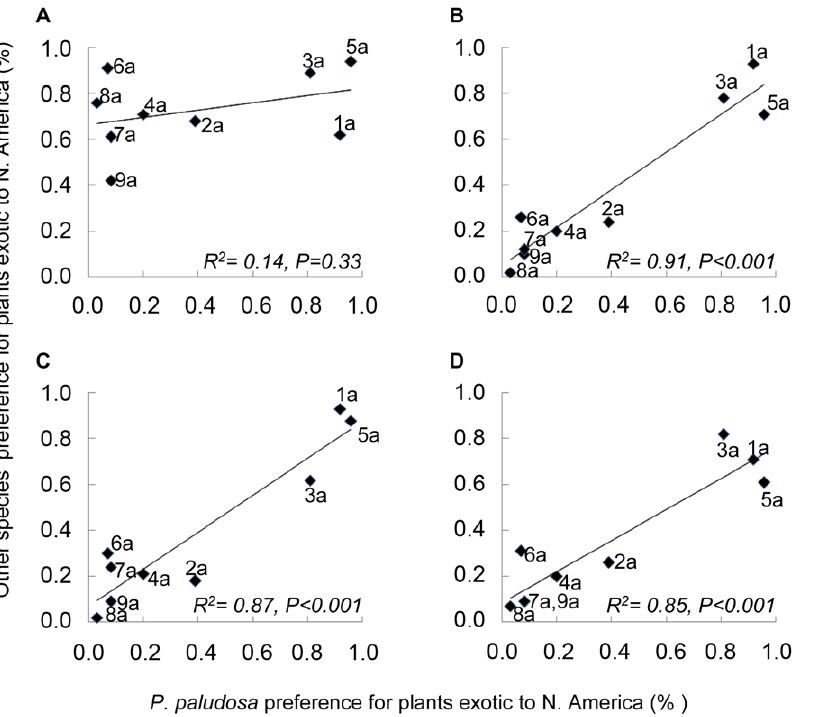
Figure 2. Plant preferences of the native P.paludosa correlated with preferences of the other herbivores. Preferences for all species were calculated as the percentage of plant consumed that was exotic to North America. Linear trend-lines and associated R 2 and p-values are provided. (a) P. spiculifer , (b) P. canaliculata , (c) P. insularum , (d) P. haustrum.